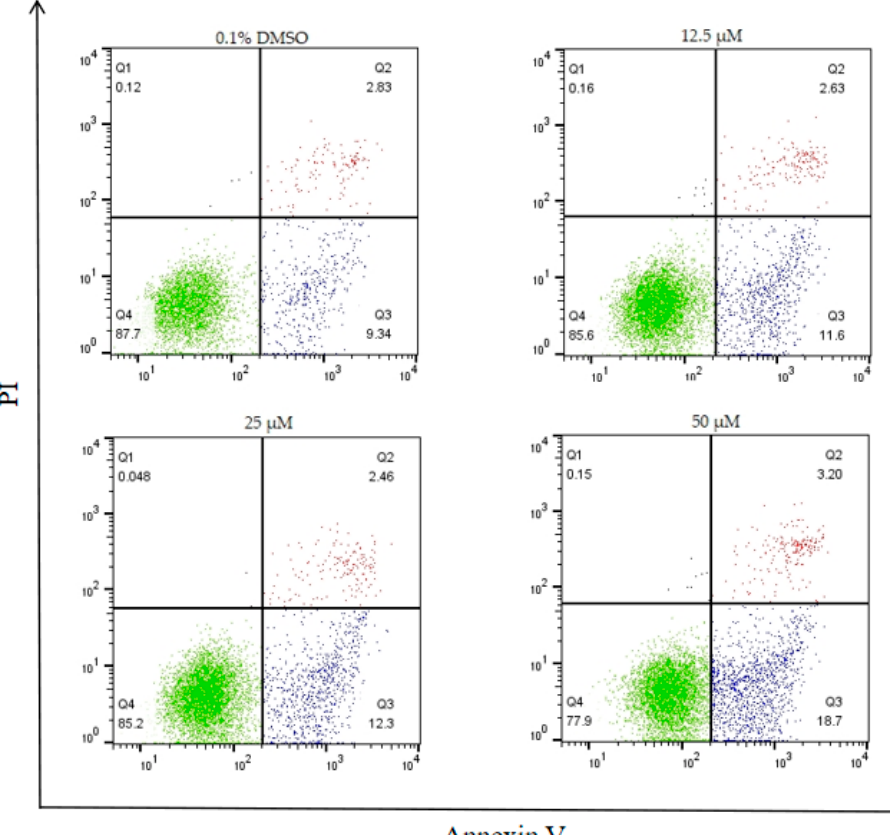
Figure 4. Flow cytometry analysis of SJSA-1 cells after 24 h incubation with A2 at concentration of 12.5 µM, 25 µM, 50 µM and subsequent staining with Annexin V and propidium iodide. Q3 and the percentage means the proportion of the early phase apoptosis cells and Q2 and the percentage means the proportion of the late phase apoptosis cells.